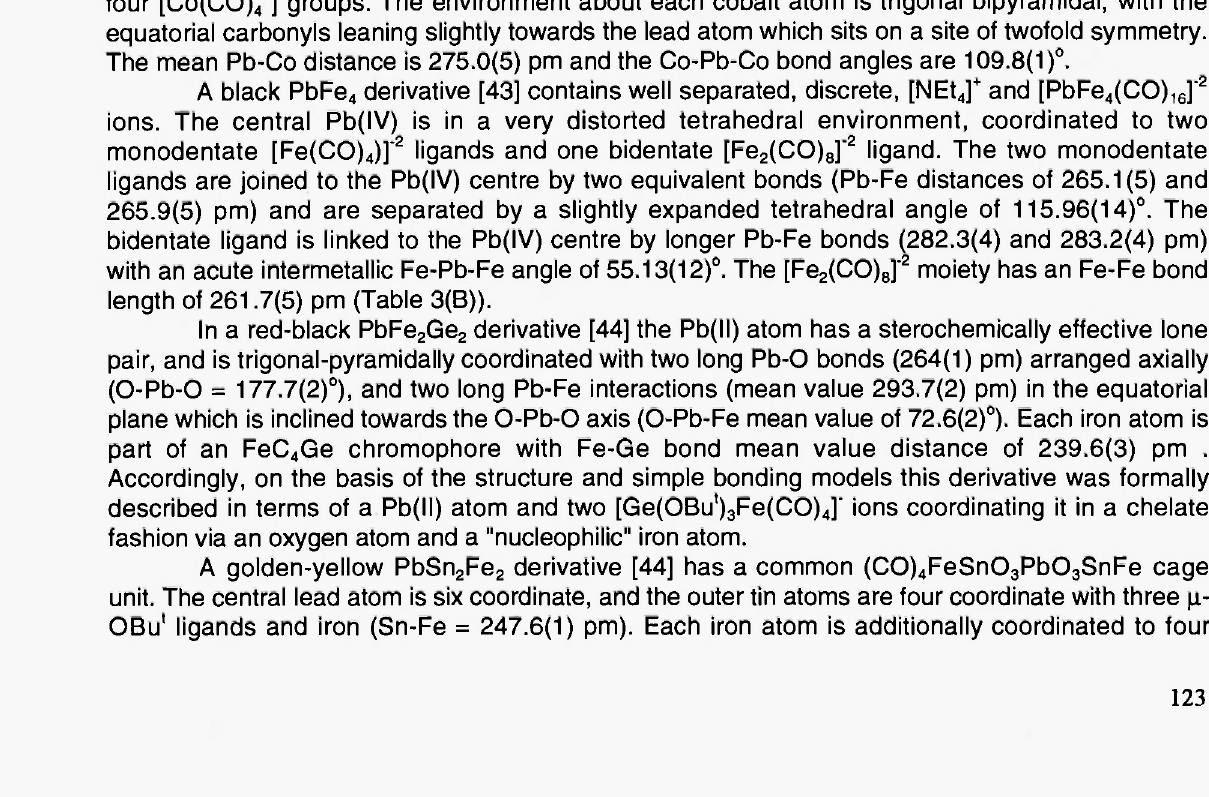
Fig. 4. Structure of Pb{Fe(CO) 4 } 4